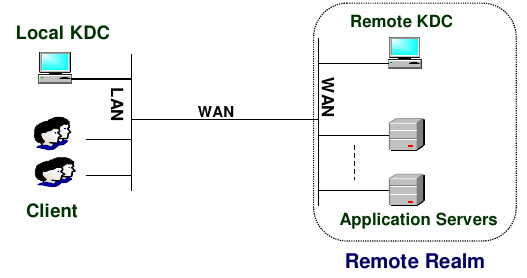
Figure 5. A Test Scenario With a Remote Realm Table 2. The computational times of Encryption and Decryption Operations Protocols and Operation